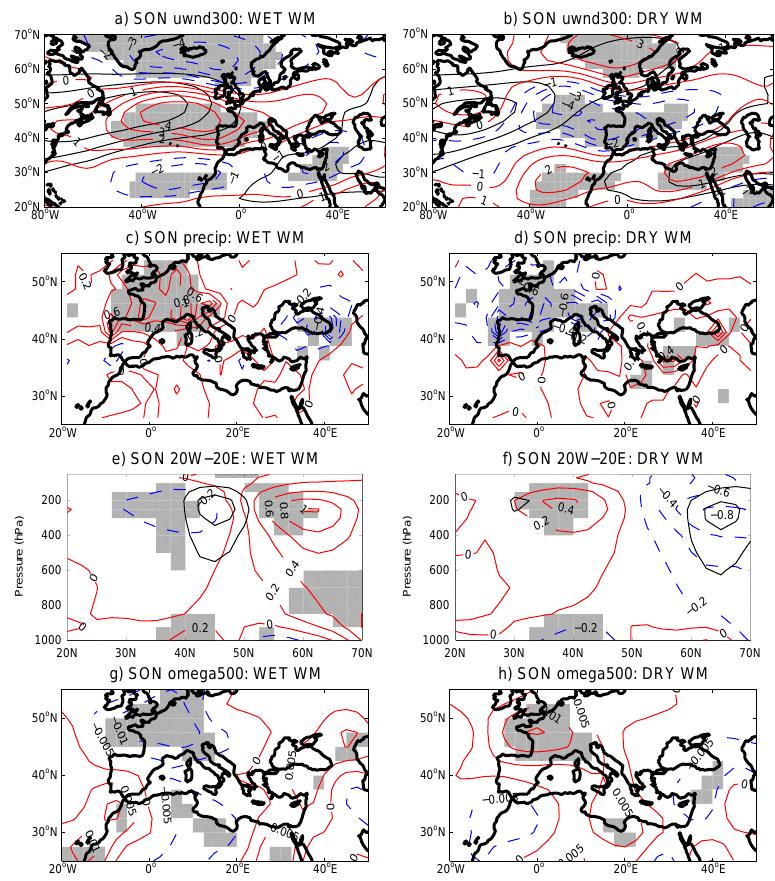
Fig. 11. Fall composite analysis: years when the WM was wetter than normal in the left panels; years when the WM was dryer than normal in the right panels; positive values in red, negative values dashed in blue, 95% significance shaded in gray. (a, b) 300hPa zonal wind mean (black contours, 5ms − 1 interval beginning at 15ms − 1 ) and its anomaly ms − 1 ; (c, d) rainfall anomaly (mmday − 1 ); (e, f) meridional ageostrophic wind ms − 1 and zonal wind (black contours, 2ms − 1 interval beginning at 2ms − 1 ) anomaly, vertical cross section zonally averaged between 20 ◦ W and 20 ◦ E; (g, h) vertical velocity anomaly (Pas − 1